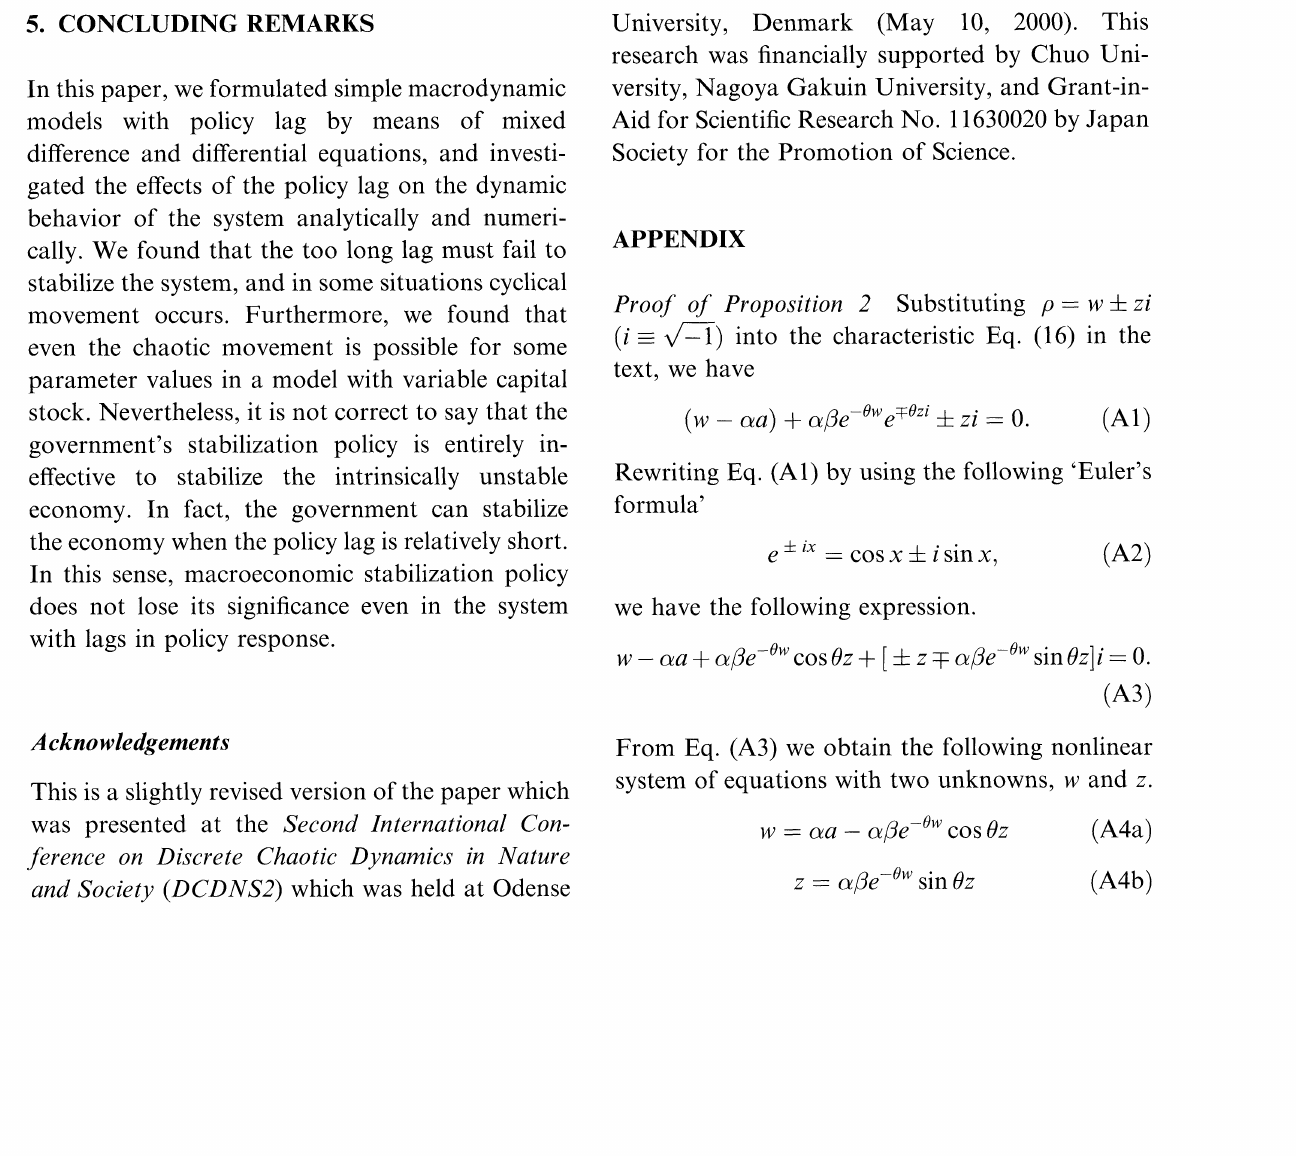
FIGURE 13 Bifurcation diagram of Y when/3= 4.1 (parameter: